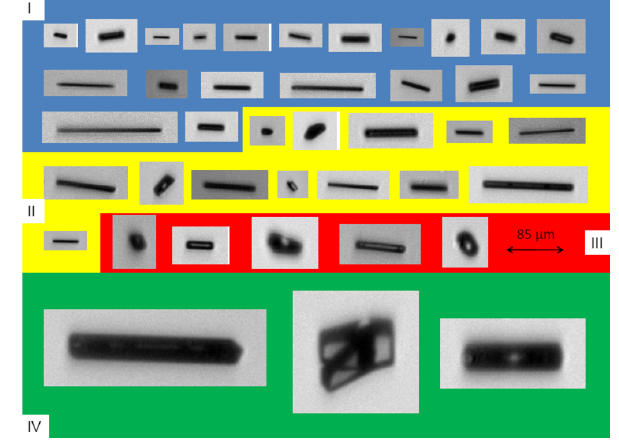
Fig. 11. Ice crystal habits of experiment HALO02 18 obtained by Figure 11. Ice crystal habits of experiment HALO02_18 obtained by PHIPS during four 3 PHIPS during four different time slots showing phases of habits and different time slots showing phases of habits and frequency of occurrences throughout the 4 frequency of occurrences throughout the experiment. 5